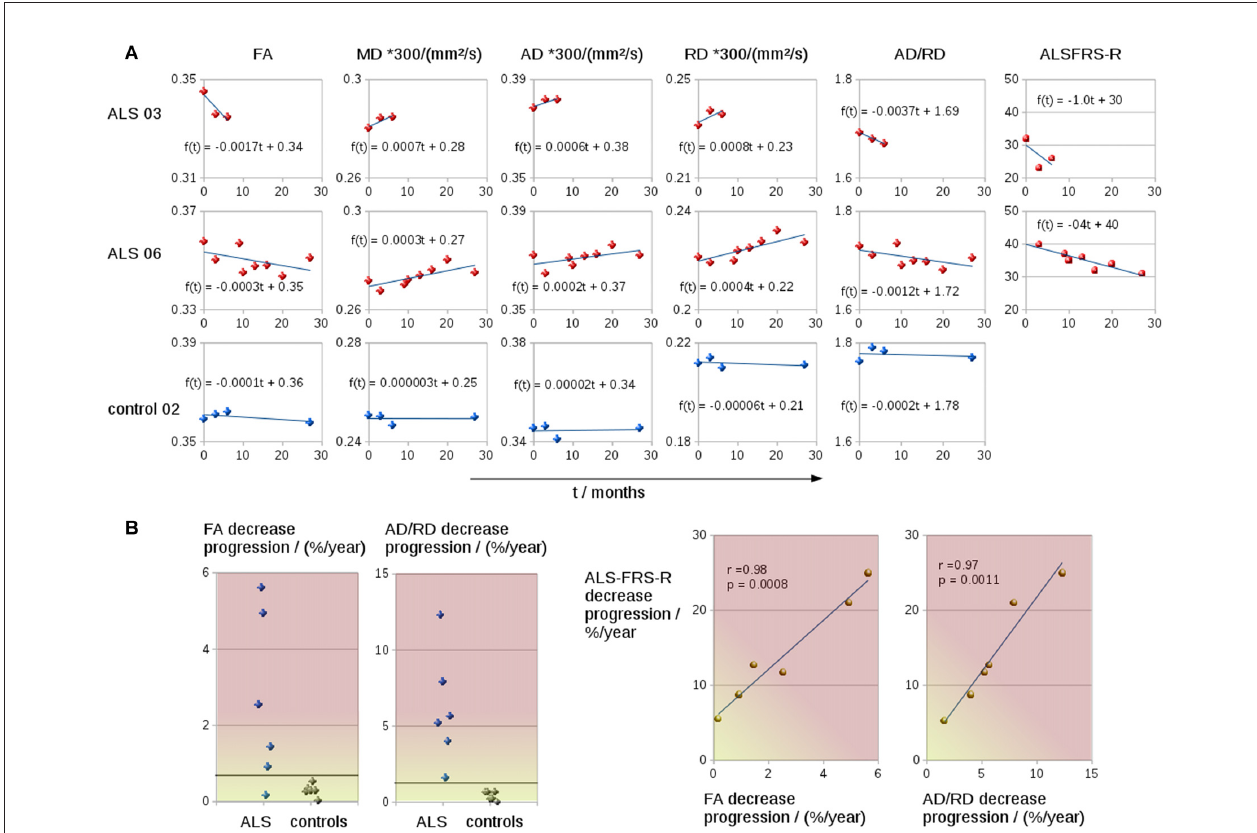
FIGURE 3 | (A) Charts of DTI metrics (FA, MD, AD, RD, the ratio AD/RD) and ALS-FRS-R alterations during the course of disease of two representative ALS patients (one fast progressor, one slow progressor) and one representative control. (B) FA and AD/RD decrease progression in the CST for six ALS patients and six controls. FA and AD/RD decrease progression correlated significantly with ALSFRS-R